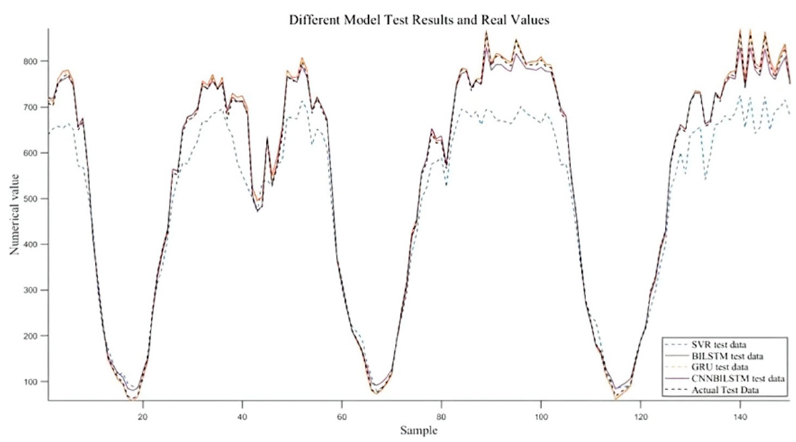
Figure 9. 15-minute forecast result graph.